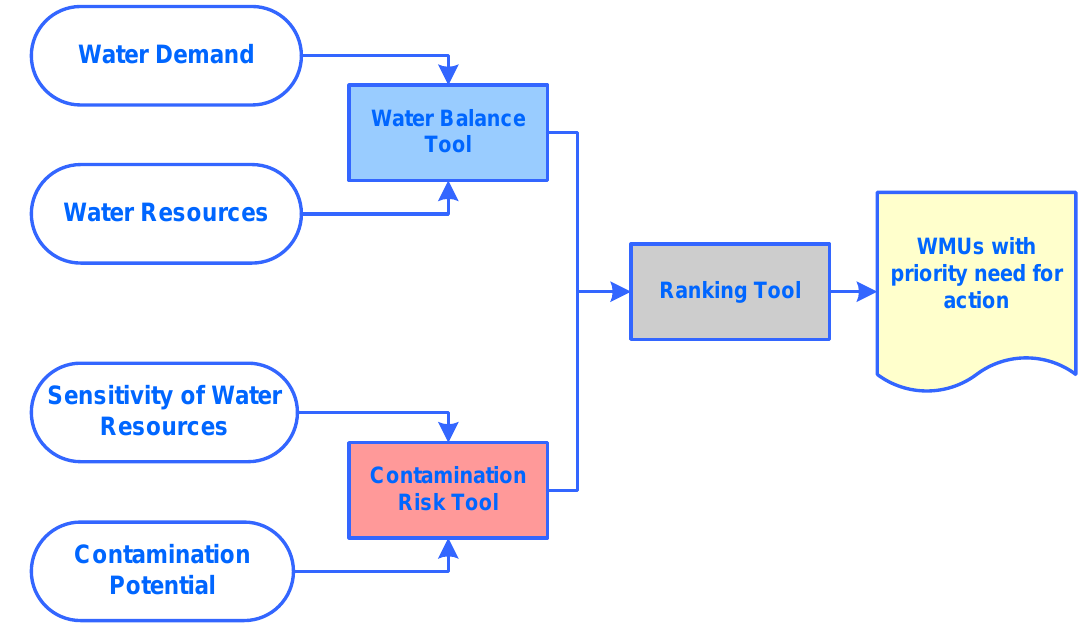
Figure 3. Framework for the Planning and Decision Support